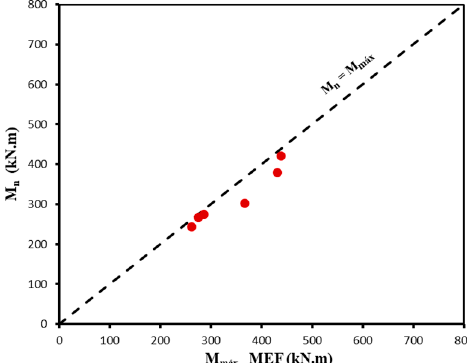
Figure 12. Comparison of flexural strength estimations of the proposed method with FE models results for stiffened base plates.